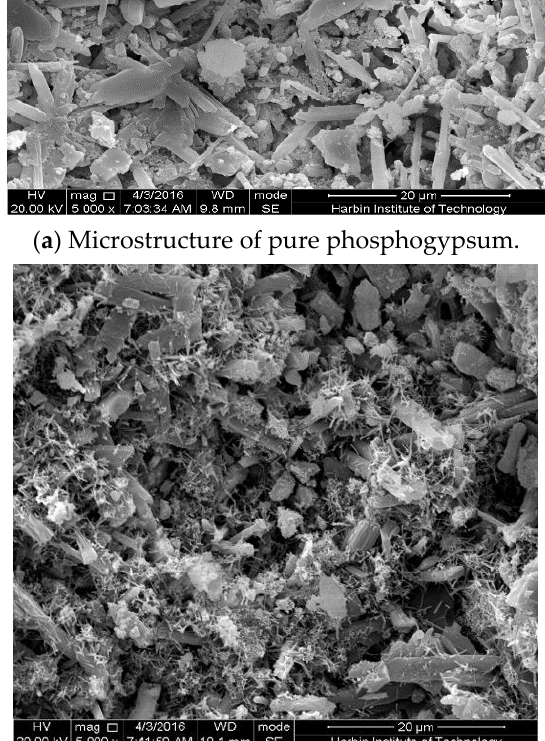
Figure 7. The scanning electron microscope (SEM) photos of phosphogypsum.